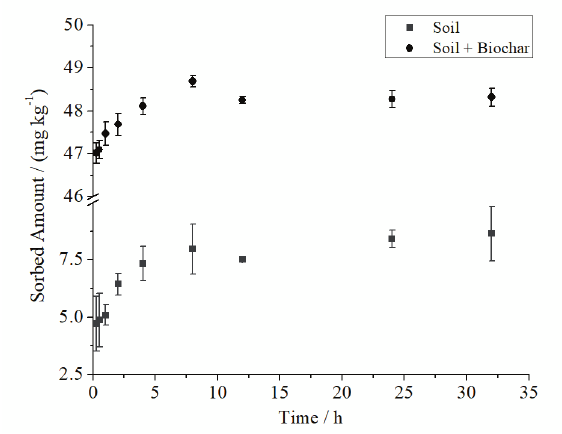
Figure 3 - Pareto chart of the standardized effects of factors particle size (1) and percentage biochar/soil (2) for CMZ sorption evaluation.